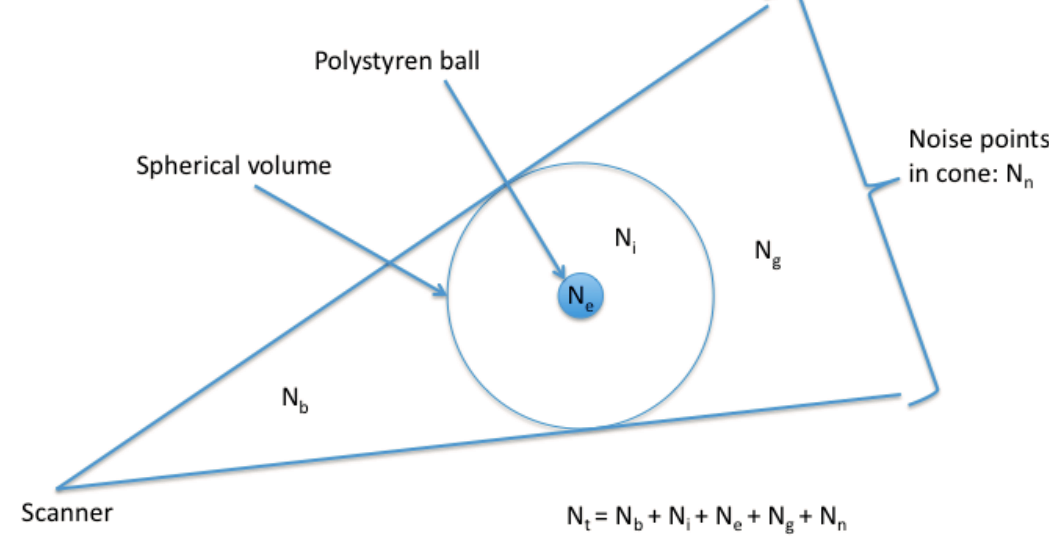
Figure 3. Schematic view of LiDAR return counts around a calibration volume. N t is the